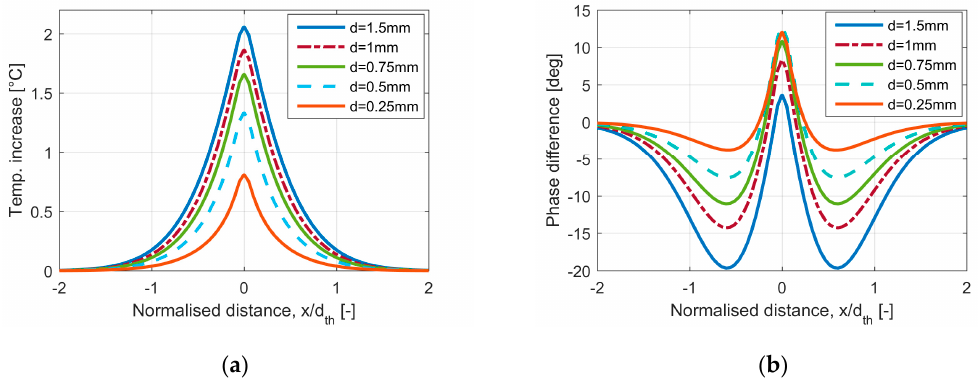
Figure 5. Temperature ( a ) and phase difference ( b ) around cracks with different depths after a 0.1 s pulse duration.